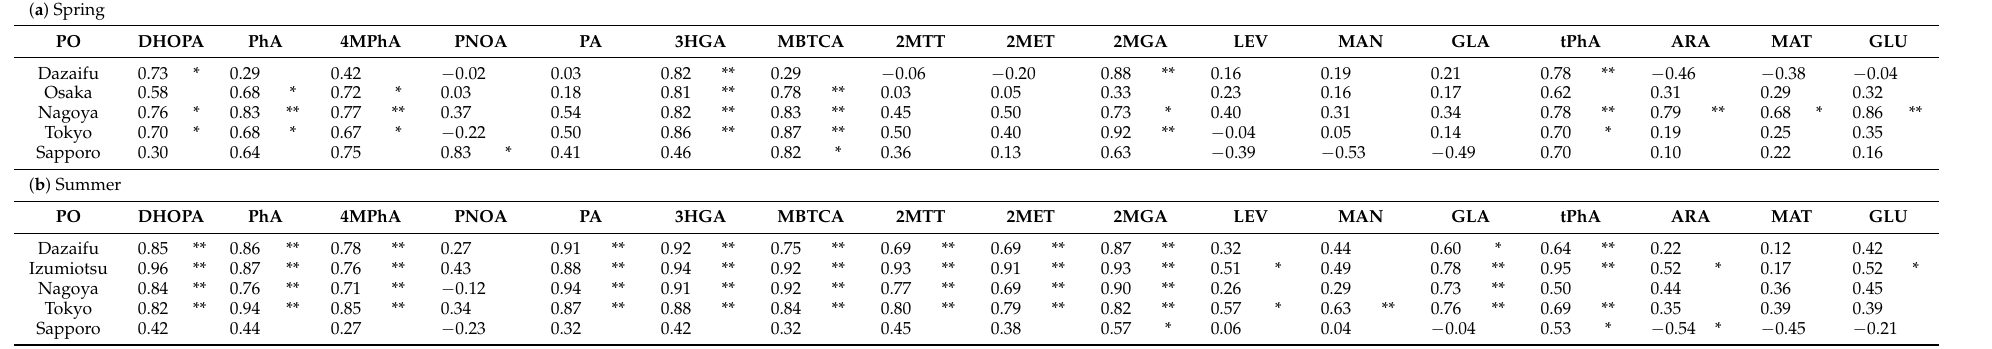
Table 4. Correlations between PO and organic tracers during ( a ) spring and ( b ) summer at each sampling site.